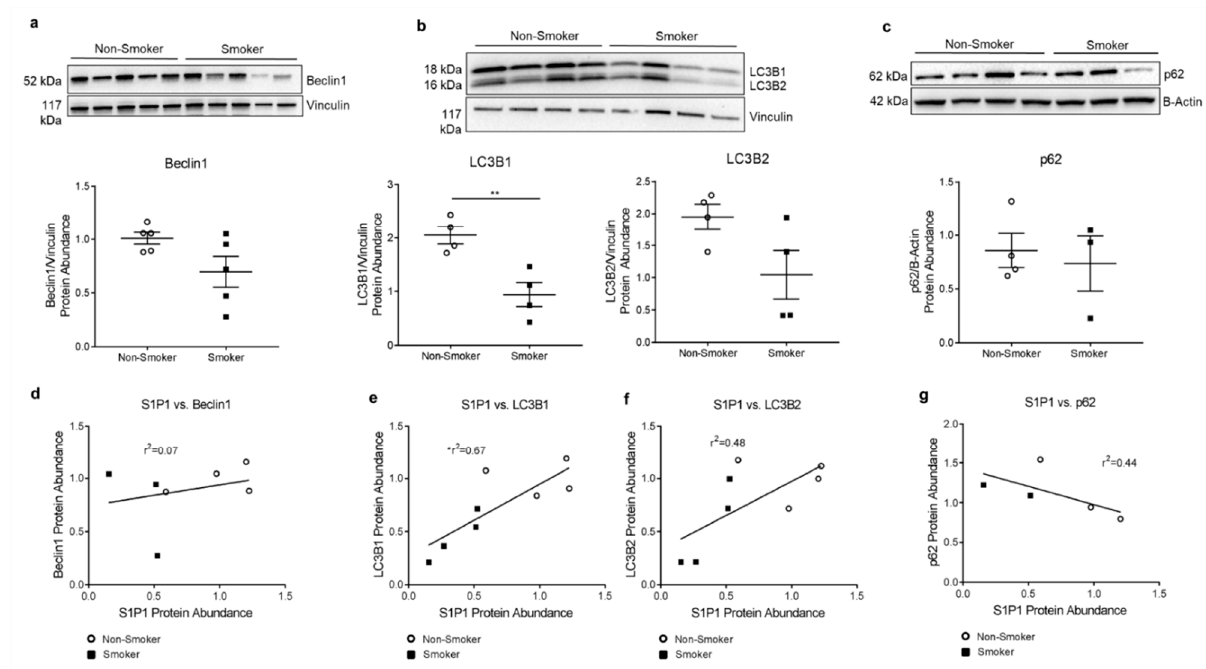
Figure 4. Autophagy in HLMVECs from Smokers. ( a – c ) Representative Western blot and densitometry analysis with vinculin ( a,b ) or actin ( c ) as loading control in non-smoker and smoker HLMVECs of ( a ) beclin1 abundance, 25 µg ( p = 0.07); ( b ) LC3B1 and LC3B2, 20 µg protein per well (** p = 0.007. LC3B2 p = 0.078.); ( c ) p62, 20 µg protein per well ( p = 0.69). All graphs ( a – c ) show data points, each representing an individual donor; horizontal lines are mean ± SEM. Two-tailed unpaired Student’s t -test used for statistical analysis. ( d – g ) Correlations between ( d ) S1P1 and beclin1. r 2 = 0.07; p = 0.55. ( e ) S1P1 and LC3B1. r 2 = 0.67; * p = 0.01. ( f ) S1P1 and LC3B2. r 2 = 0.48; p = 0.06. ( g ) S1P1 and p62. r 2 = 0.44; p = 0.22. All graphs ( d – g ) show data points, each representing an individual donor. Only HLMVECs which were matched by donor and passage number were included in correlation analysis. Each densitometry value was first normalized to the average control (non-smoker) densitometry obtained from its respective Western blot. Pearson’s correlation coefficients with two-tailed p -values used for statistical analyses.